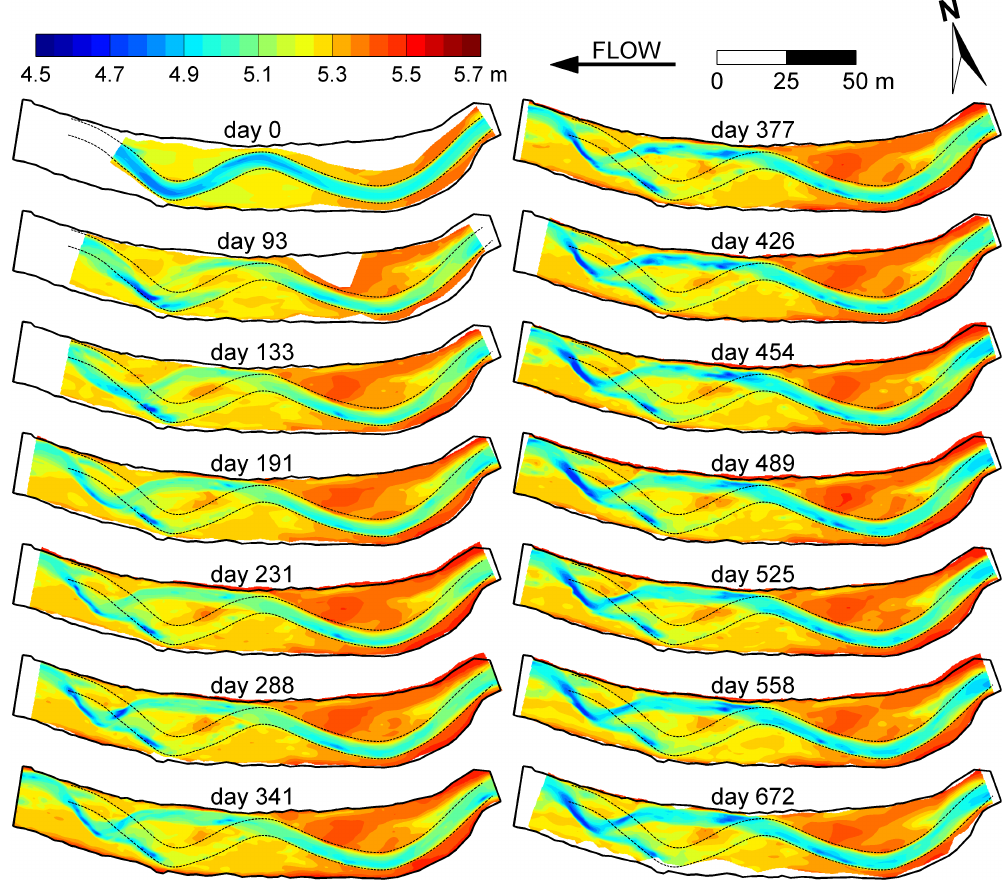
Figure 4. DEMs of all 14 morphological surveys. The number of days indicate the time since channel reconstruction. The dashed black lines indicate the location of the channel banks of the reconstructed channel. The solid black line surrounding the DEMs indicates the extent of the seventh morphological survey (day 341). Elevation is indicated in metres above mean sea